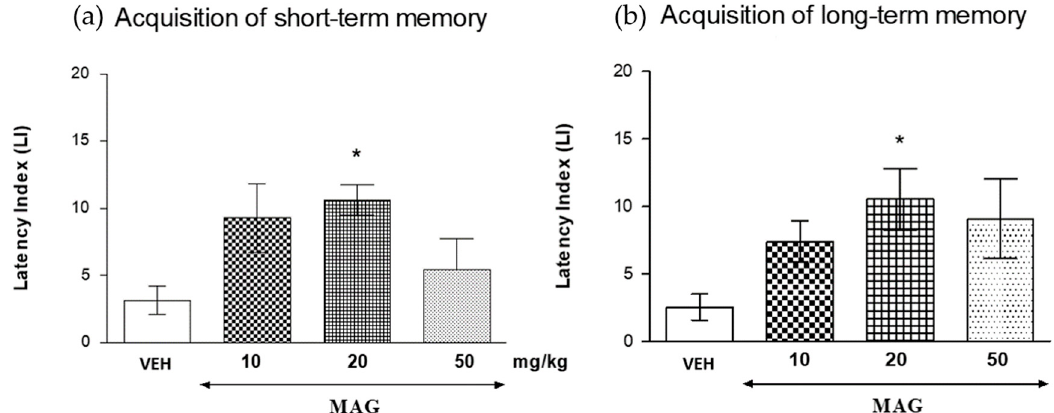
Figure 6. Effects of an acute magnoflorine (MAG) injection on the latency index (LI) during the short-term or long-term acquisition trial using the PA test in mice. MAG (10, 20 and 50 mg/kg; i.p.) or vehicle (VEH) were administered: 30 min before the first trial and animals were re-tested 2 h (for short-term memory ( a )) or 24 h (for long-term memory ( b )) later; n = 11–12; the means ± SEM; * p < 0.05 vs. VEH-treated control group; Tukey’s test.